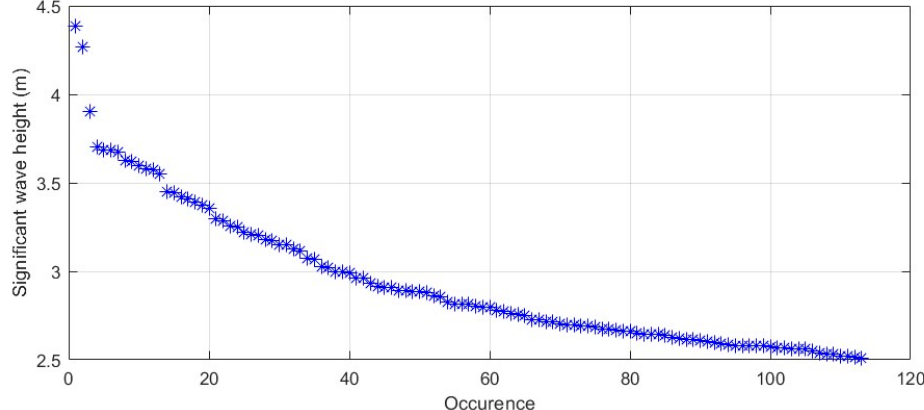
Figure 2. A plot of the peak wave heights of the 113 storm events at the Dubai coast coming from the northwest direction in the period 1979–2018.